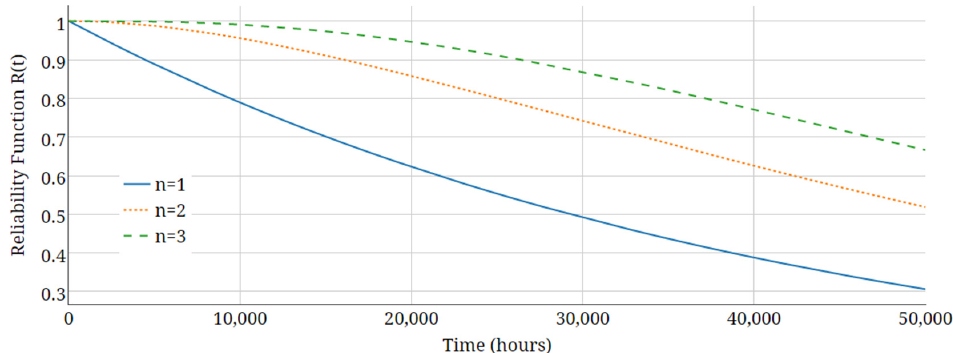
Figure 7. The effect of series redundancy on reliability of FC.